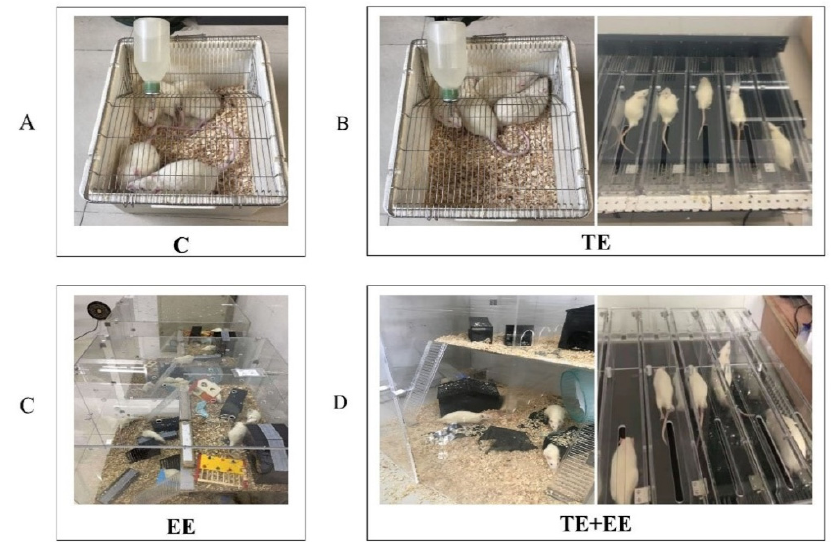
Figure 1. Study groups: ( A ) Control (C); ( B ) Treadmill Exercise (TE); ( C ) Enriched Environment (EE); ( D ) Treadmill Exercise Combined with Enriched Environment (TE + EE).